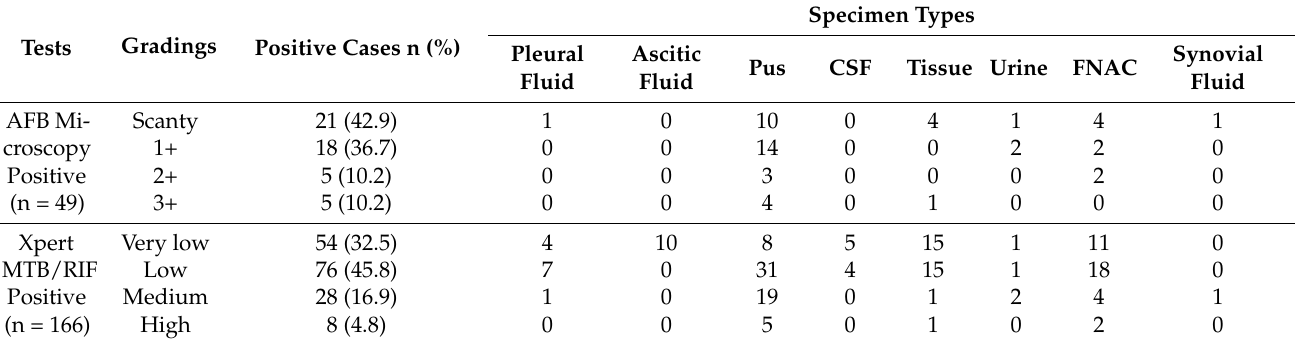
Table 3. Burden of MTBC isolates among different EPTB specimens determined by AFB microscopy and Xpert MTB/RIF assay.